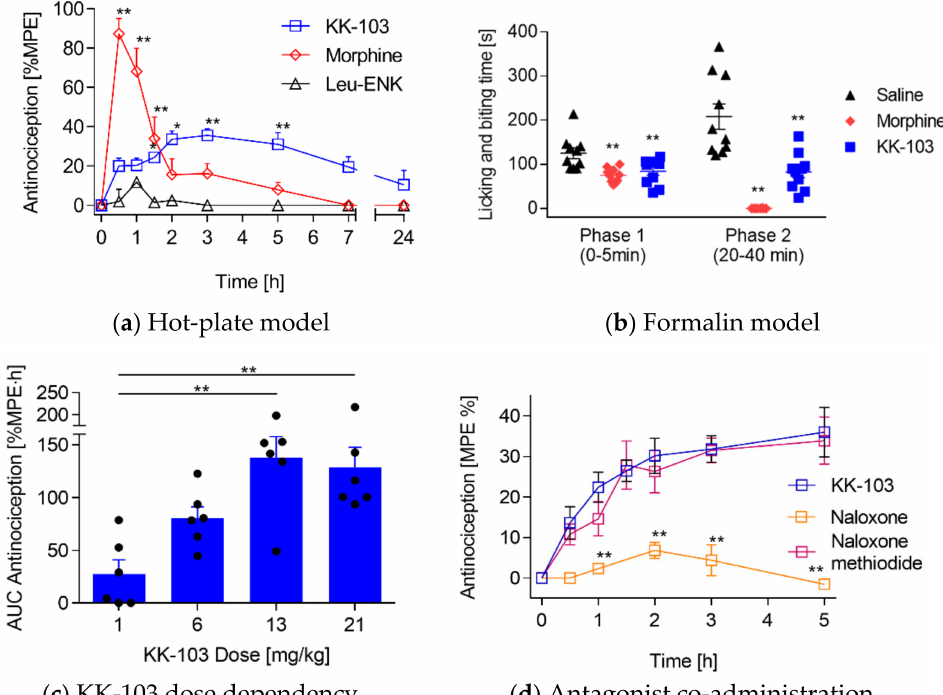
Figure 5. Antinociceptive activity in female CD-1 mice with s.c. injection of drugs. ( a ) Hot-plate model comparing the %MPE of Leu-ENK (13 mg/kg), KK-103 (13 mg/kg) and morphine (10 mg/kg), ** p < 0.001, * p < 0.02 compared to Leu-ENK. ( b ) Formalin injection test comparing KK-103 (13 mg/kg), morphine (10 mg/kg) and vehicle with responses representing the total time of mice spent licking and biting in phase 1 (0–5 min) and phase 2 (20–40 min) of the nociceptive response to formalin injection. ** p < 0.001 compared to vehicle. ( c ) Dose-effect relationship of KK-103 in the hot-plate model with overall antinociception represented as the AUC of the %MPE plot, ** p < 0.001, n.s denotes not signifi- cant. ( d ) Hot-plate model comparing the activity of co-administrated antagonist Nlx (i.p. 3 mg/kg), or Nlx-M (i.p. 4 mg/kg) with K-103 (13 mg/kg) + vehicle, ** p < 0.05. Data = mean ± SEM ( n = 6) for ( a – c ); Data = mean ± 95% confidence interval ( n = 10) for ( b ). Statistical comparisons were performed using a two-way ANOVA with multiple comparisons and Tukey post hoc test ( a , d ), one-way ANOVA with Tukey post hoc test ( b , c